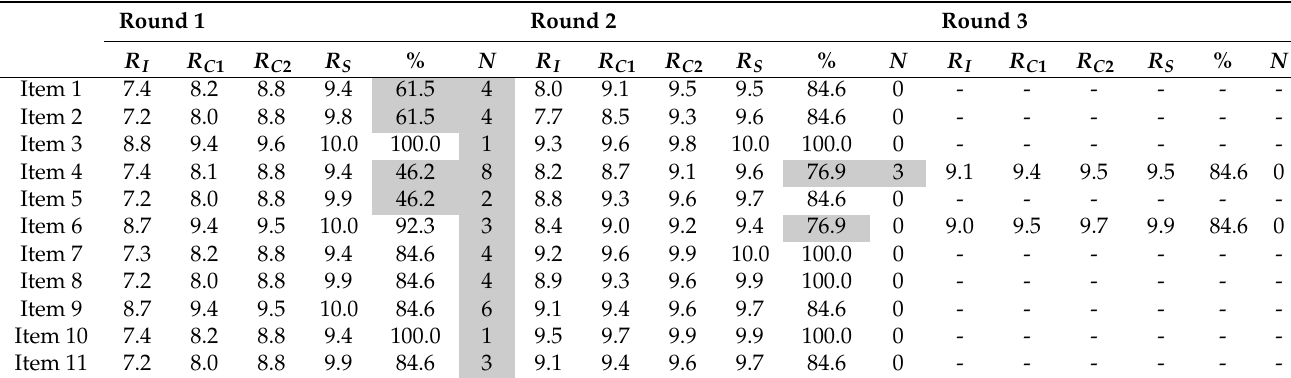
Table 1. The results of the fuzzy Delphi rounds, with the reasons why an item must be included in the following round highlighted in